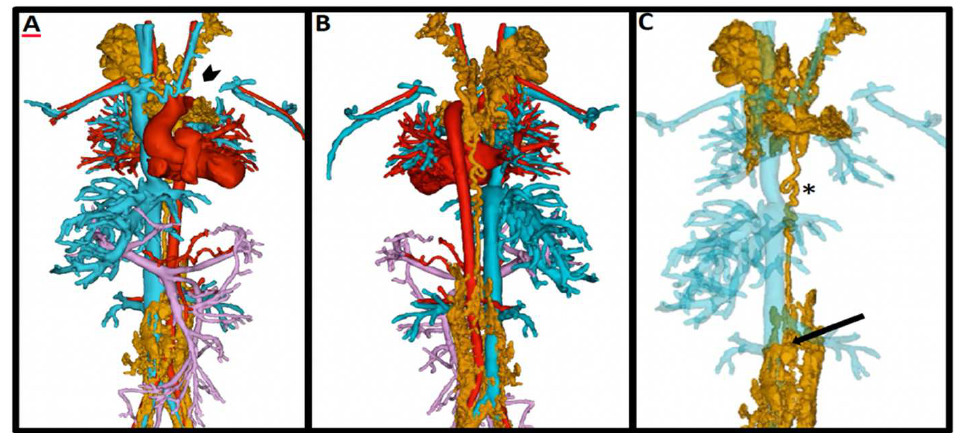
Figure 14. Ferumoxytol-enhanced 4D MRA (MUSIC) with overlayed dynamic contrast-enhanced MR lymphangiogram (DCMRL). Panels ( A – C ): Overlay of the lymphatic (gold), systemic venous (blue), arterial (red), and portal venous anatomy (lavender) arising from a dilated cisterna chylii (black arrow). In this patient with single ventricle anatomy and Fontan circulation, there is complete occlusion of the innominate, left internal jugular, and left brachiocephalic veins (arrowhead). The DCMRL shows a dilated and tortuous thoracic duct (*) with decompressing lymphoceles into the neck secondary to thoracic duct outlet obstruction. Figure courtesy of Dr. Sanjay P. Sinha, Dr. Arash Bedayat, and Takegawa Yoshida.